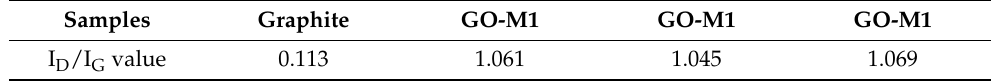
Table 2. I D /I G values of graphite powder and three types of